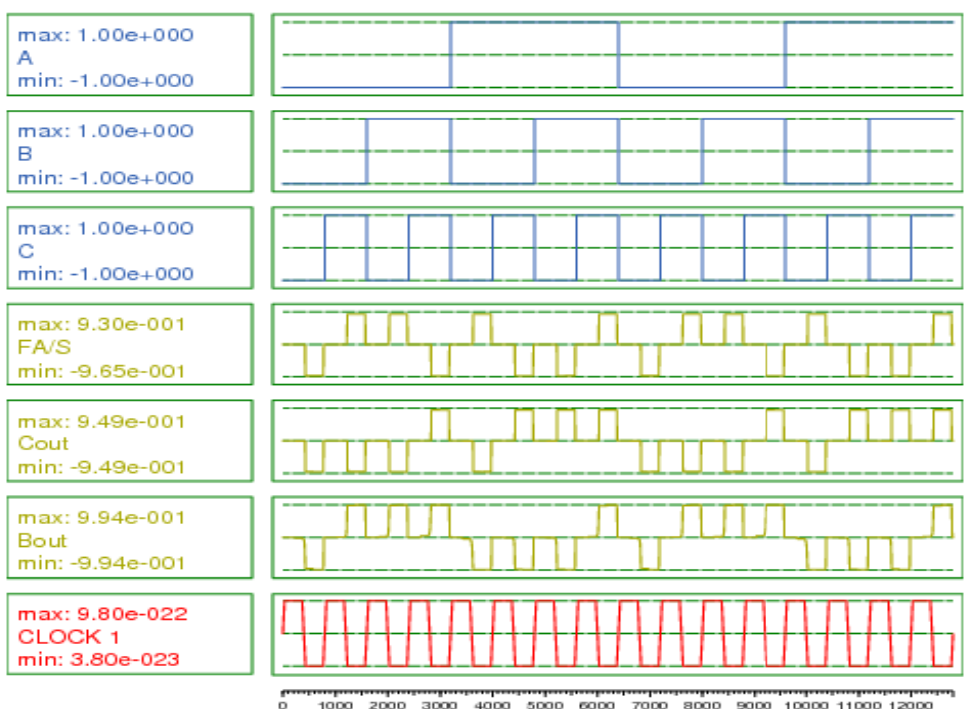
Figure 19. Simulation results for the proposed (C) Full Adder/Full Subtractor circuit.